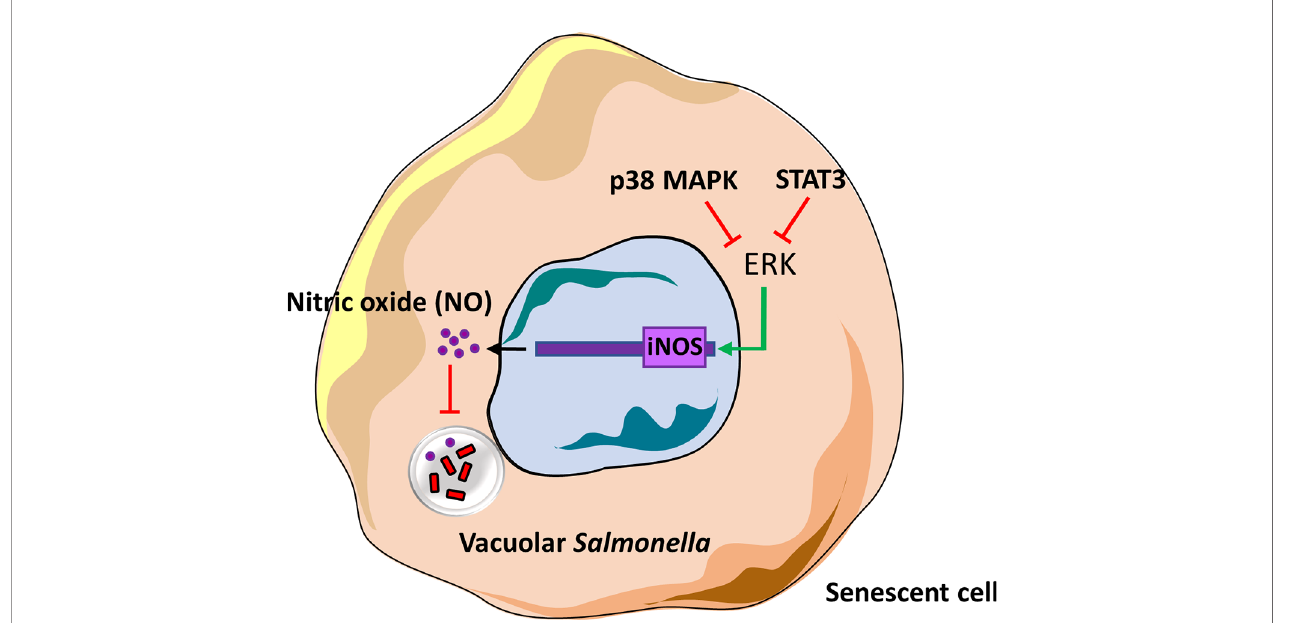
FIGURE 5 | Model of iNOS regulation by p38 MAPK, ERK and STAT3 in senescent